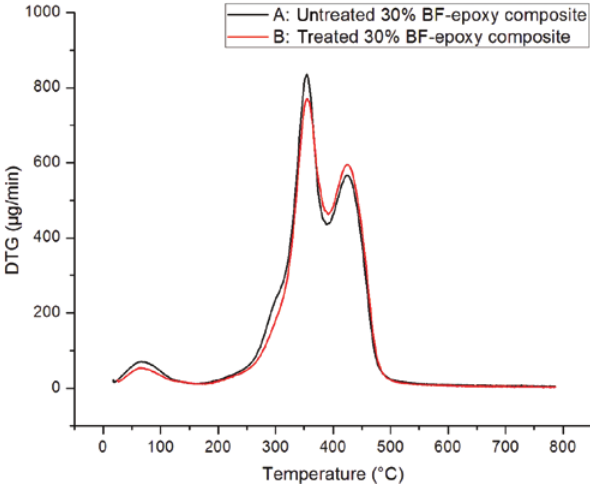
Figure 9: DTG thermogram of untreated and treated 30% BF-epoxy